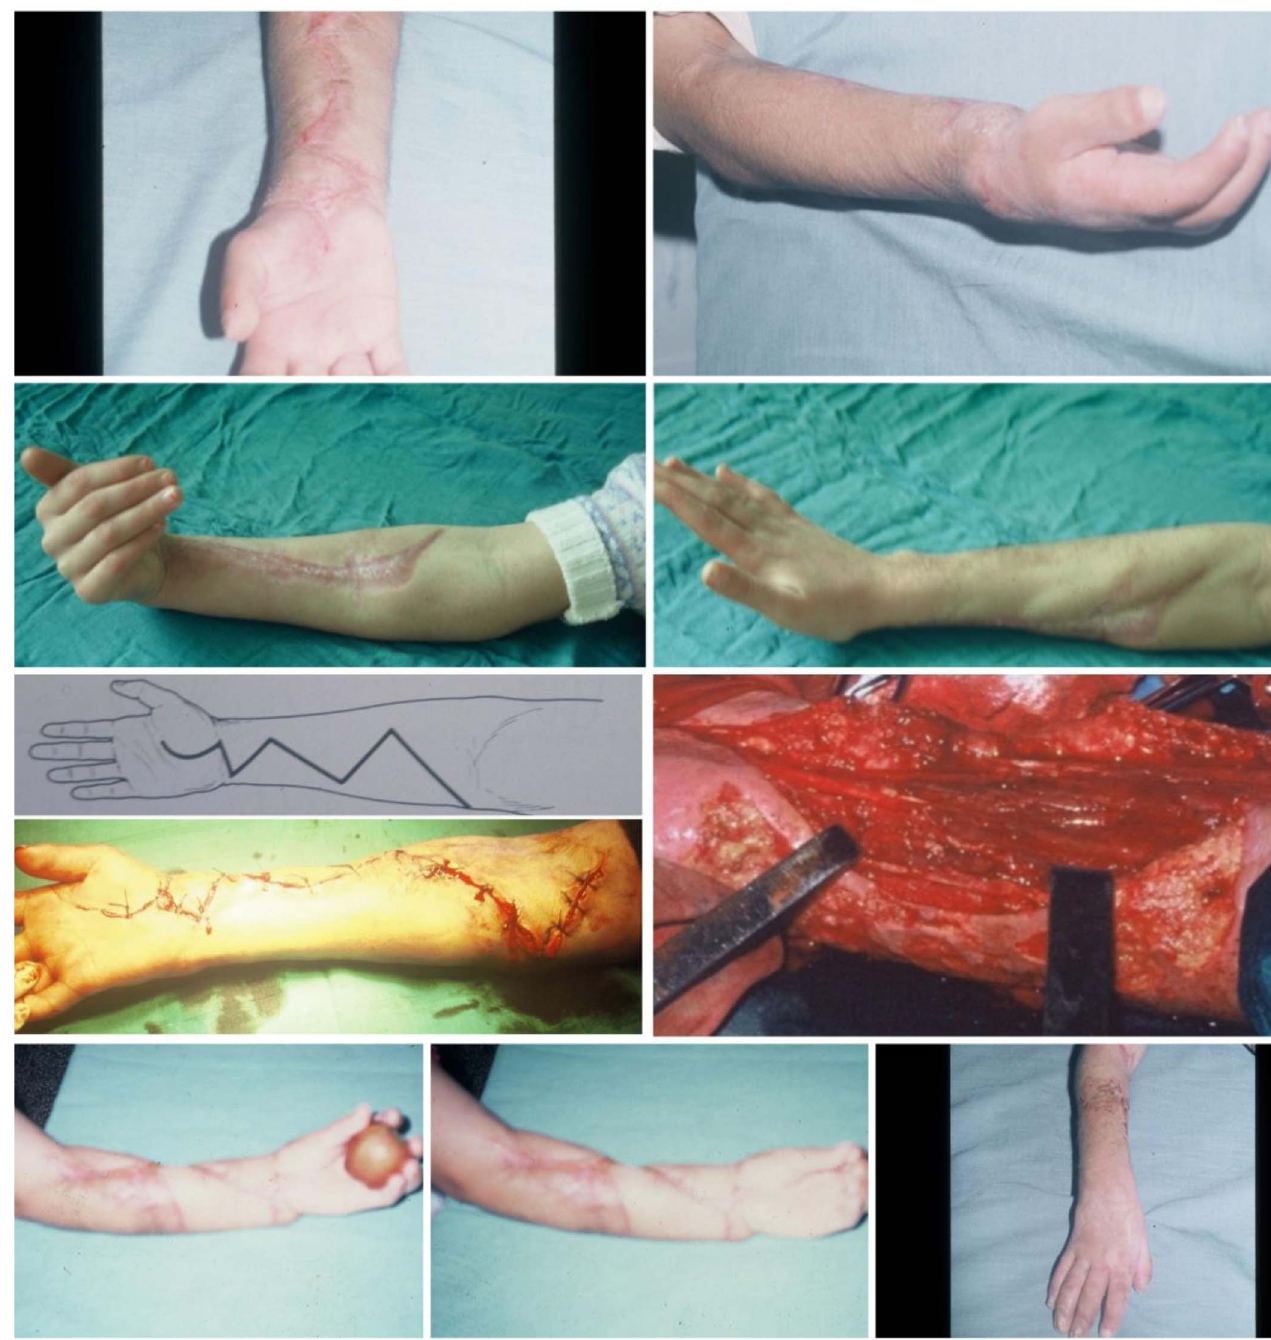
Figure 7. Five severe cases operated by fasciotomy, neurolysis, and tenolysis, which results are good or